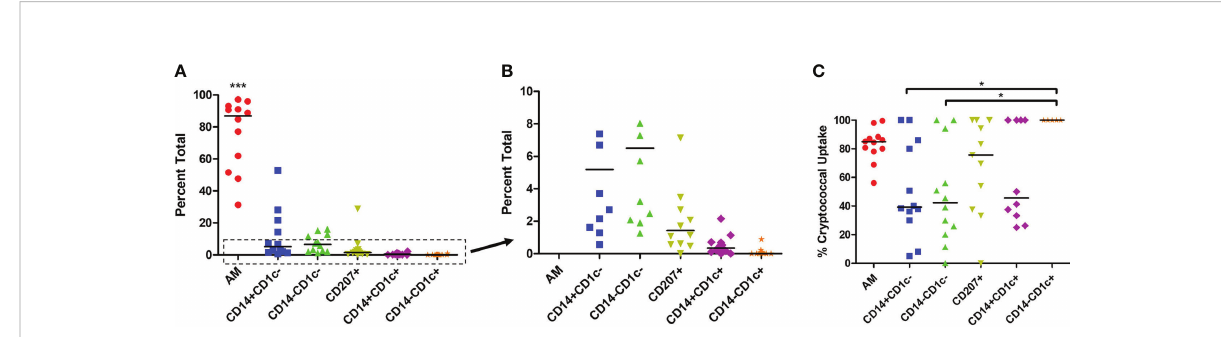
FIGURE 1 Percent Population of Each Subset Identi fi ed and Interact with C neoformans . Processed human BAL cells were incubated with fl uorescent mCherry expressing C. neoformans strain JLCN920 for 2h and then stained with fl uorescent antibodies for fl ow cytometric analysis. (A) Representation of each phagocytic APC subset shown as a percentage of total population indicated by surface markers. (B) Inset from panel (A) showing relative abundance of remaining low number subsets. (C) Percentage of uptake by each phagocytic APC subset of C. neoformans indicated as positive for mCherry. Data points shown are individual samples with black bars as median of the results of 12 samples (n=12), with each sample performed in duplicate. One-way ANOVA with Tukey ’ s Multiple Comparison Test was performed to compare each column against all others. *** indicates signi fi cantly different means of AM subset to all others ( p < 0.0001) and * represents signi fi cantly different means of indicated macrophage subset to DC subset CD14 - CD1c + ( p <